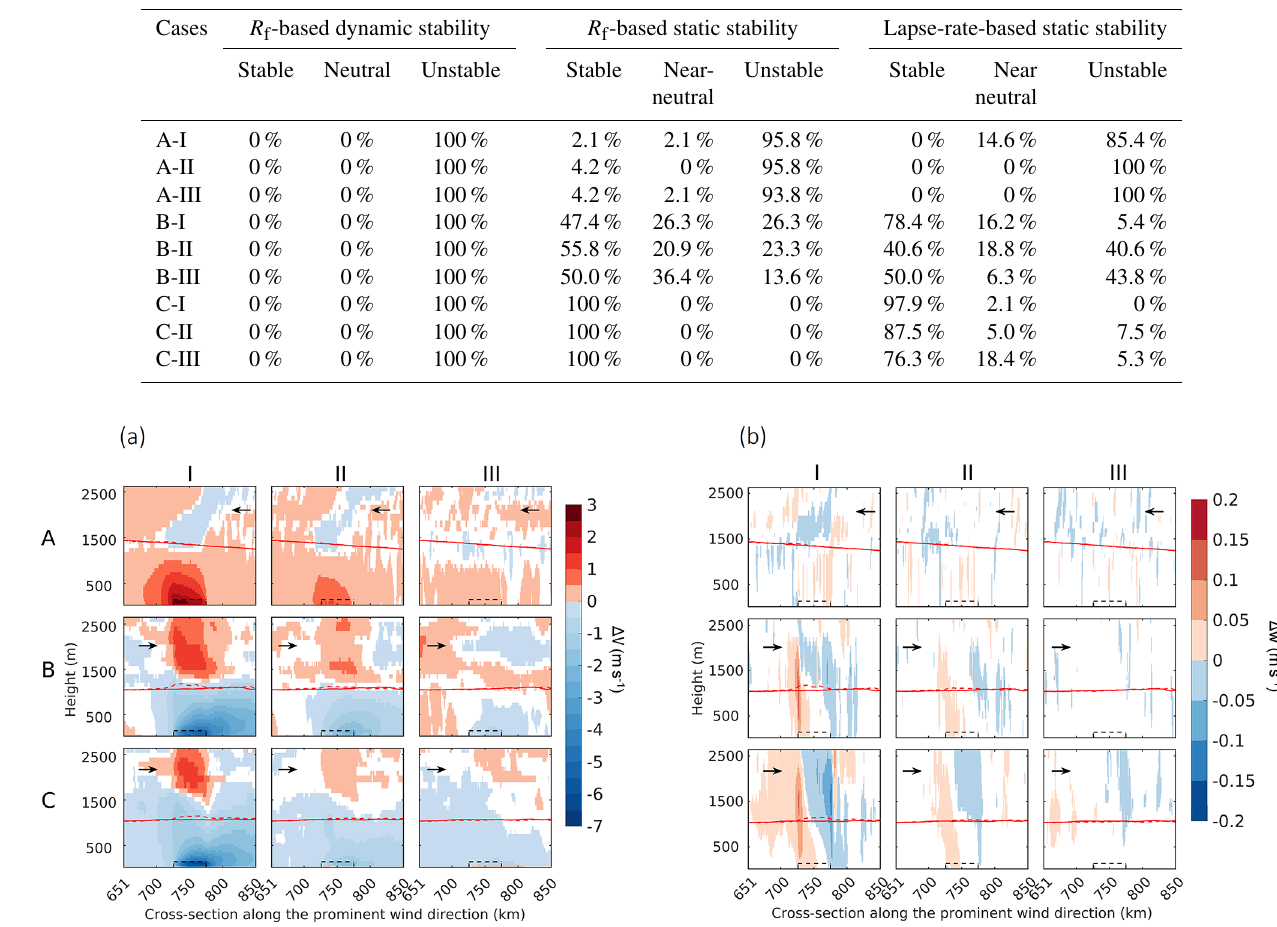
Figure 4. (a) Difference in horizontal wind velocities ( (cid:49)V ; ms − 1 ) (WF − CTRL) and (b) difference in vertical wind velocity ( (cid:49)w ; ms − 1 ) (WF − CTRL) on a vertical cross-section along the predominant wind direction for case (A) January, (B) June, and (C) July, with (I) 0.5km, (II) 1km, and (III) 2km turbine spacings. Only the statistically significant results ( p < 0 . 01) are shown here. The white colored regions represent areas where the differences are not significant. The dashed black box depicts the wind farm cross-section. The dashed red line depicts ABL height (WF case), and the solid red line depicts ABL height (CTRL case). The arrows represent the predominant wind